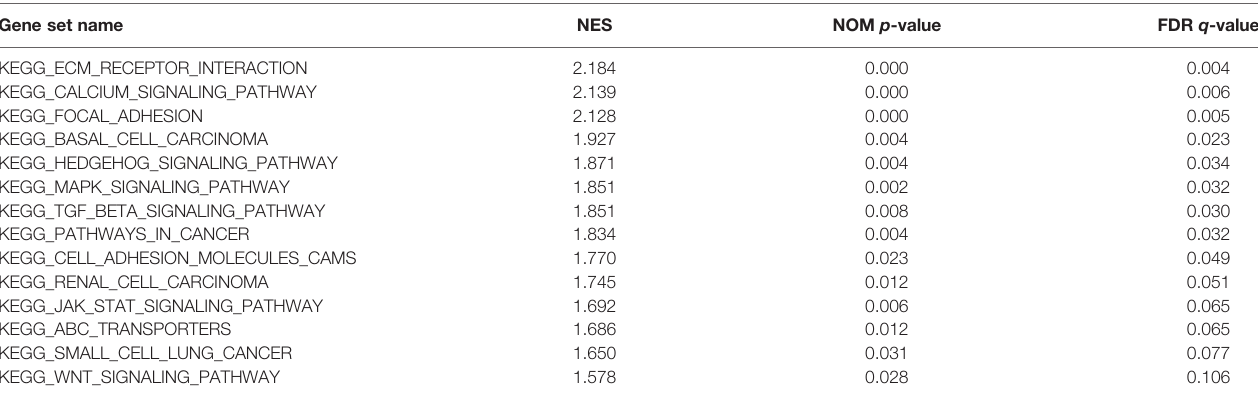
TABLE 3 | Enrichment plots from gene set enrichment